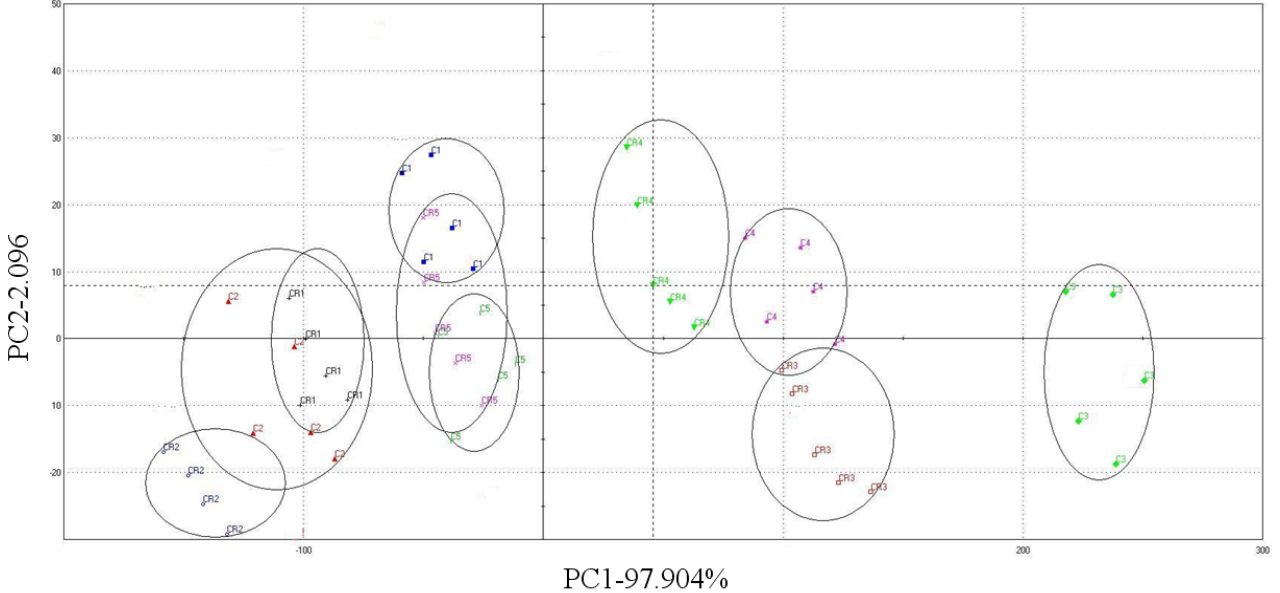
Figure 3. Principal component analysis of the data presented for PC1 and